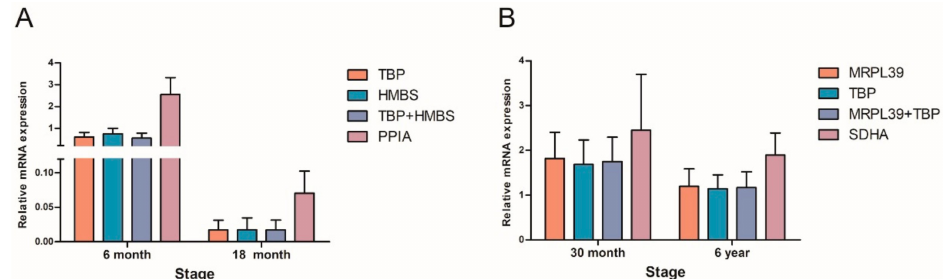
Figure 4. Relative expression levels of TET2 at the immature stage and mature stage normalized by the selected stable RGs (singly or in combination) and the least stable gene. ( A ) Immature stage, ( B ) mature